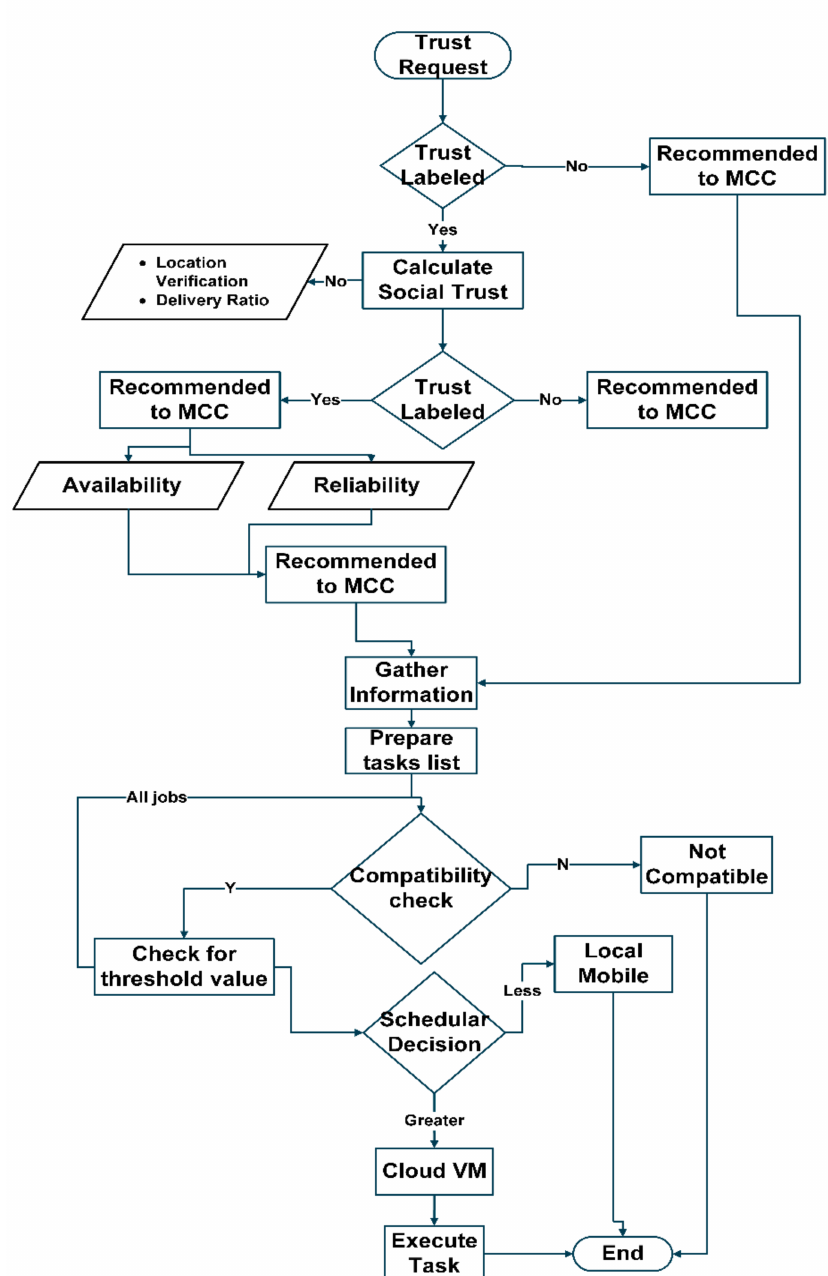
Figure 8. IoT and mobile cloud trust development flow